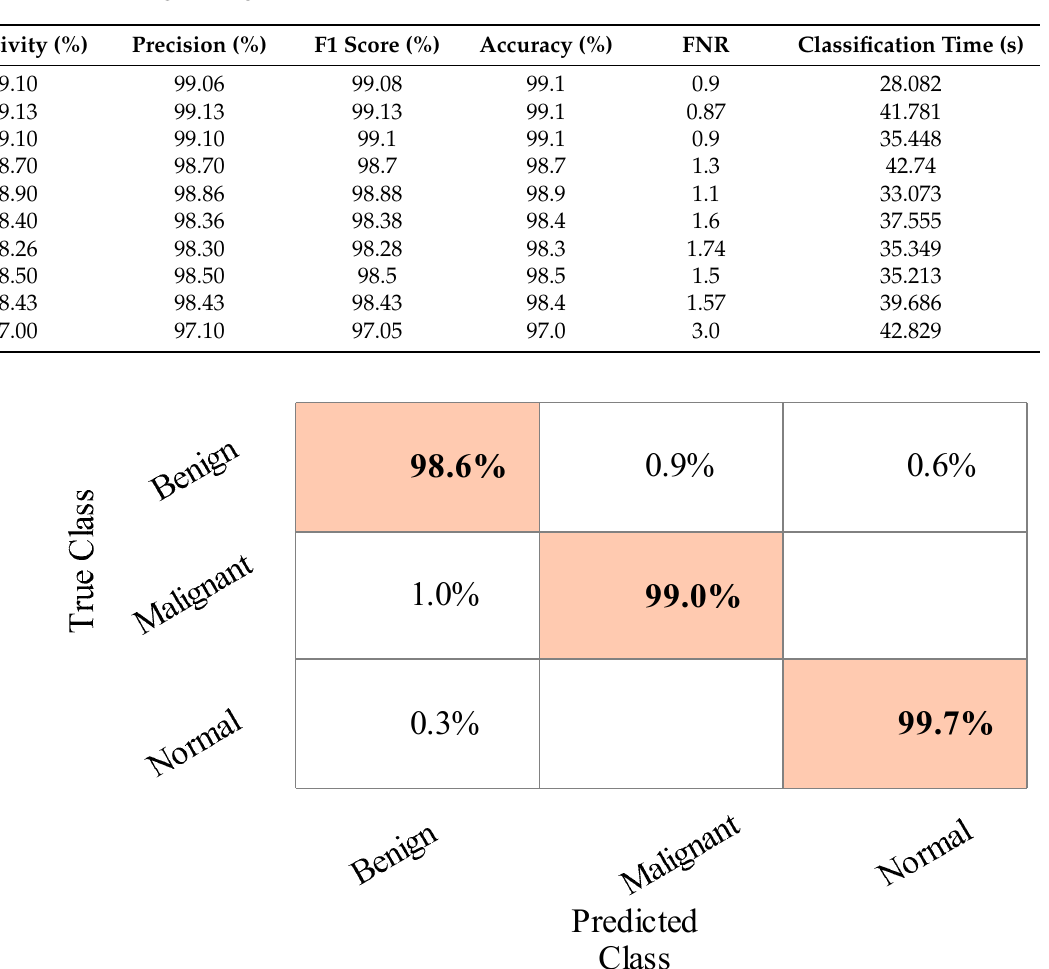
Table 6. Classification results of binary gray wolf optimization selector using ultrasound images, where the training/testing ratio is 50:50. Classifier